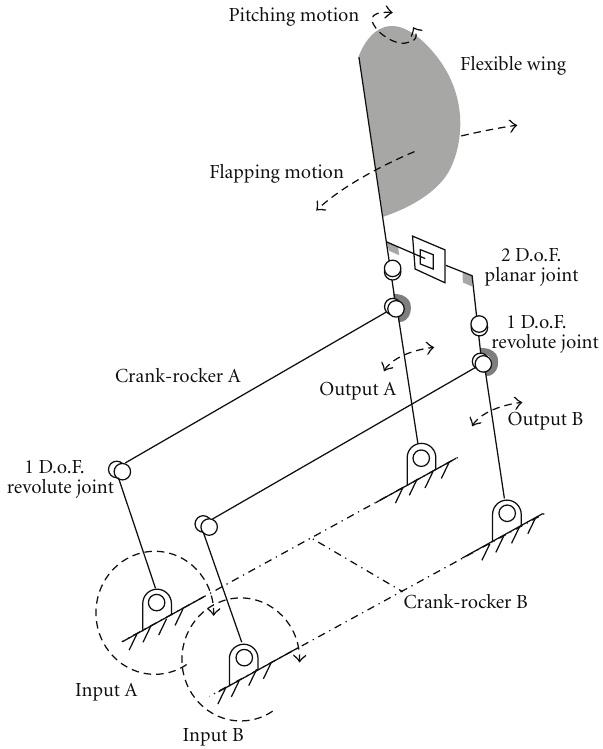
Figure 13: Rigid-body representation of the parallel crank-rocker mechanism. Full revolutions at inputs A and B produce reciprocat- ing outputs A and B, which cause the wing to flap. Introducing a phase lag between the two linkages (and hence outputs) introduces a pitching motion to the wing [35].